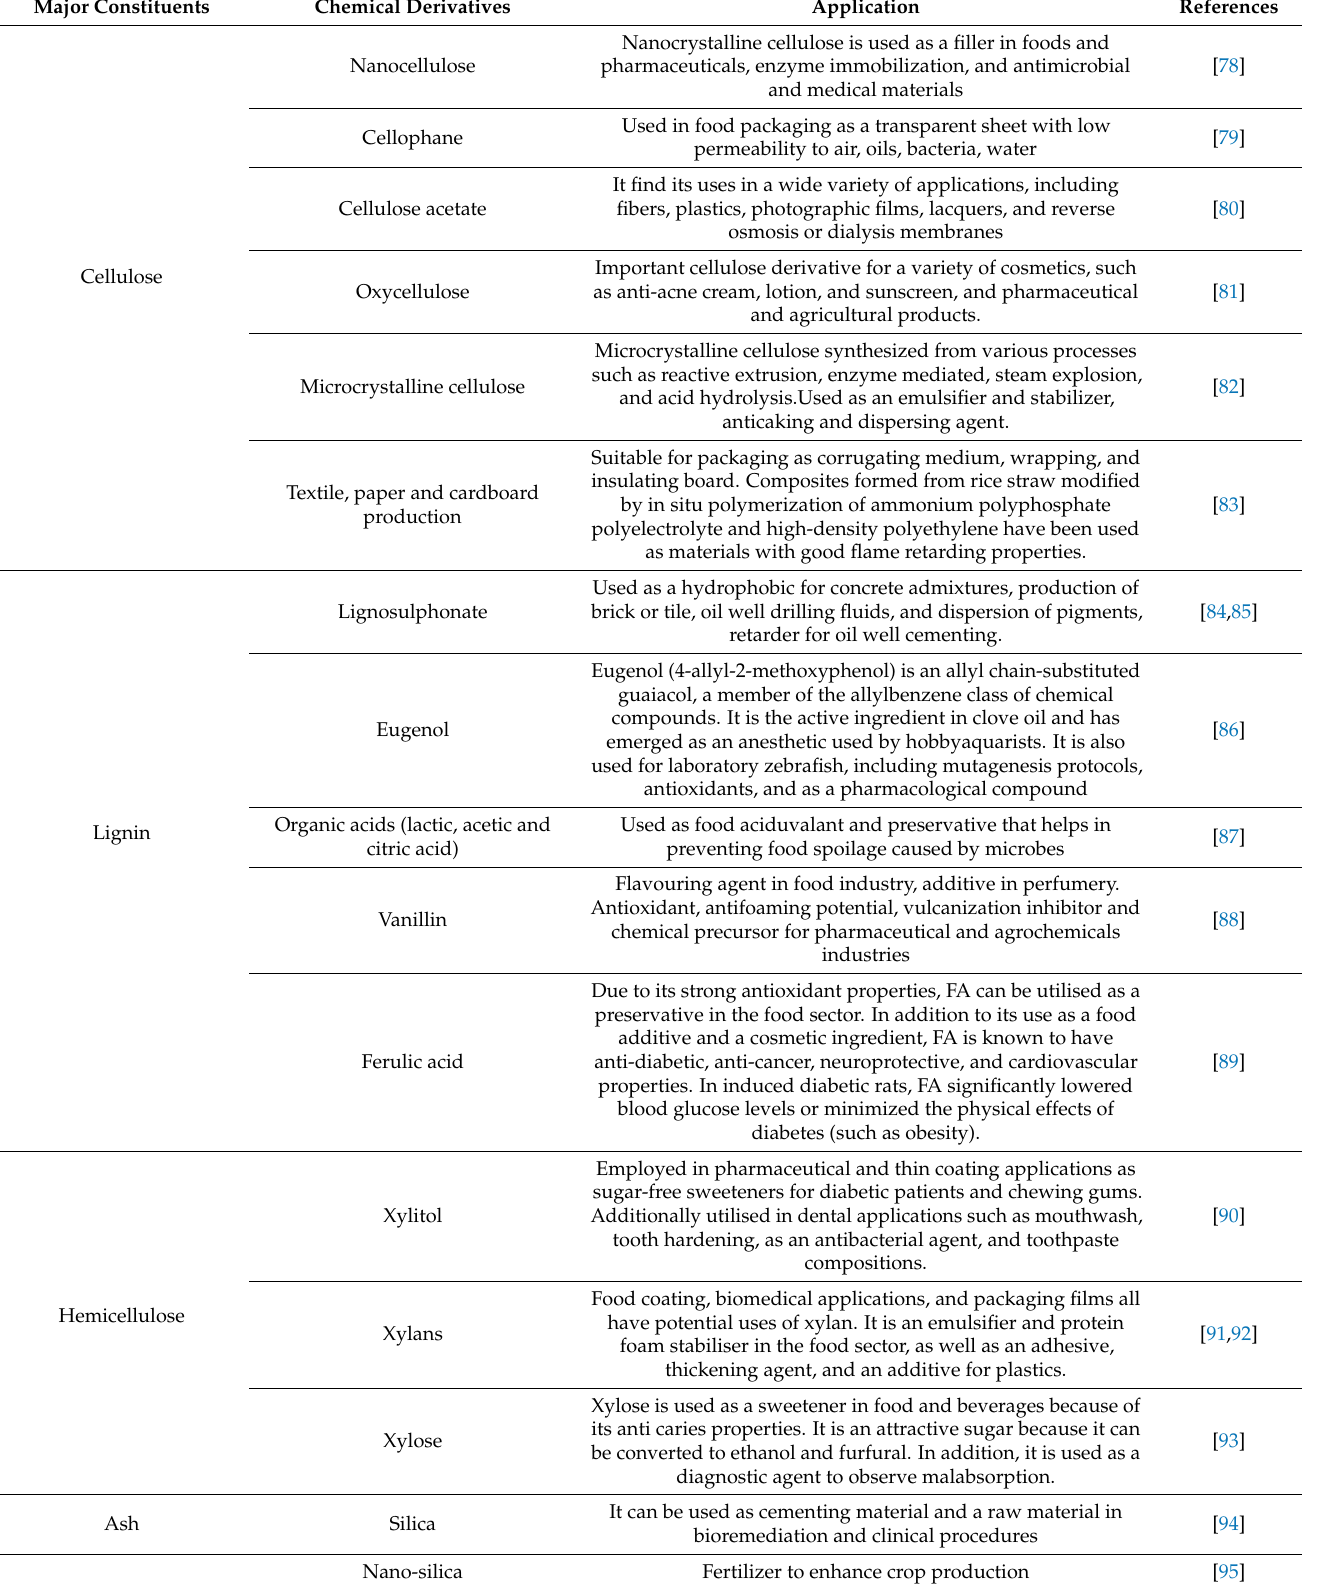
Table 2. Different chemicals derived from rice straw and their